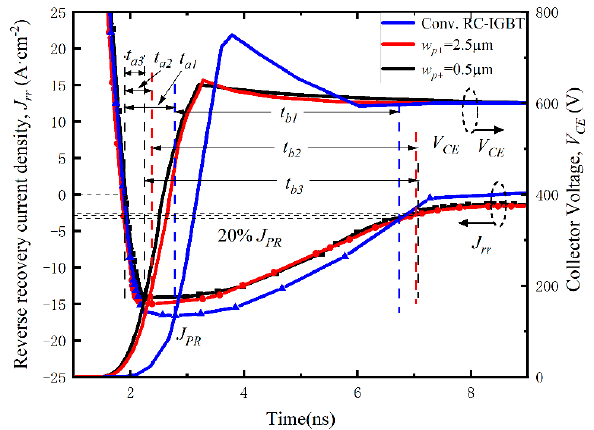
Figure 6. Reverse recovery current and collector voltage waveforms of conventional RC-IGBT and SE RC-IGBT. ( t a and t b are mentioned in Figure 2a).